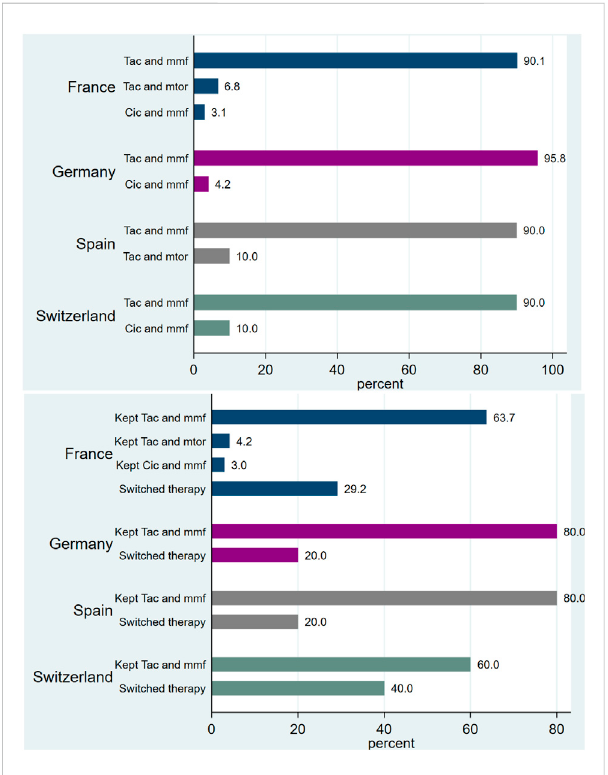
FIGURE 1 Proportion (%) of patients with immunosuppressant therapies, at baseline and at visit M12.